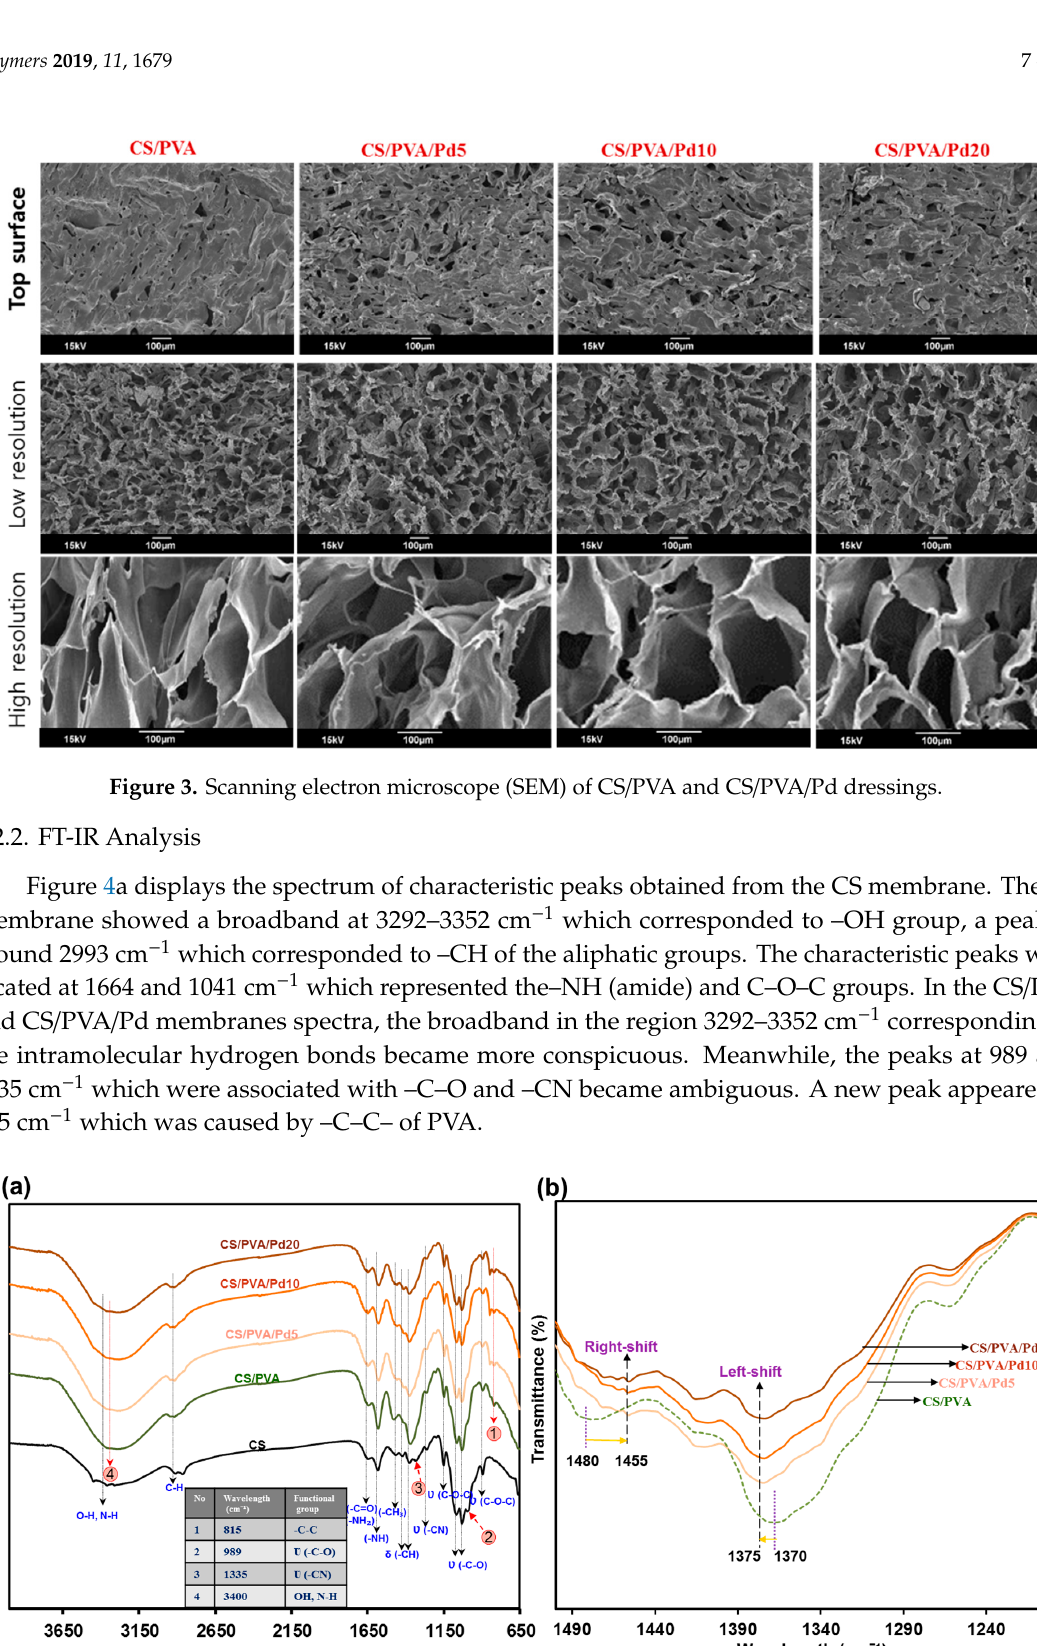
Figure 5. Thermogravimetric analysis (TGA) of CS/PVA and CS/PVA/PdNPs dressings. Figure 5 showed TGA analysis result of CS/PVA and CS/PVA/Pd membranes. The results show that all of the porous membranes had a thermal degradation temperature range from 215 °C. Under 215 °C, the compositions and properties of membrane were conserved, which totally satisfied the requirement of wound dressing thermal stability. Compared to CS/PVA, CS/PVA/Pd membranes